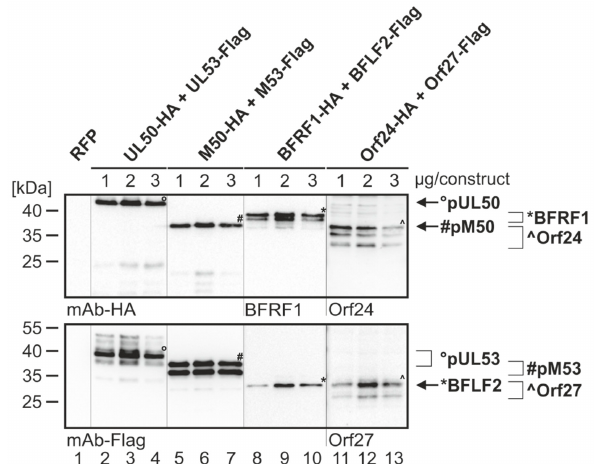
Figure 2. Expression analysis of the core NEC proteins of HCMV, MCMV, EBV and VZV. 293T cells were transiently cotransfected with constructs coding for HA-tagged pUL50, pM50, BFRF1, Orf24 or Flag-tagged pUL53, pM53, BFLF2 and Orf27 with indicated concentrations (1, 2 or 3 μ g per construct) in the respective combination, or with pDsRed1-N1 (RFP) as a control. At three d p.t., cells were harvested and lysed. Samples were subjected to standard Wb analysis using tag-specific or protein-specific monoclonal antibodies as indicated. The allocation of protein bands is given by symbols on the right referring to those in the image panels of the figure.